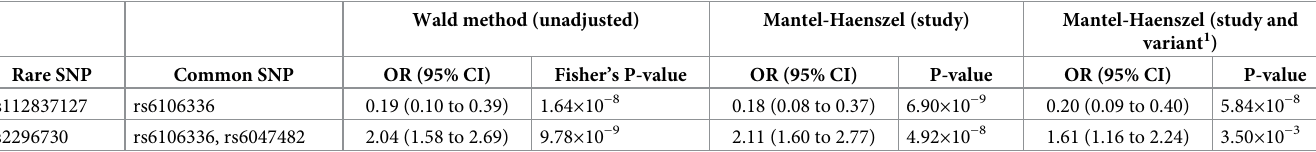
Models use a dominant allele coding for minor alleles with each individual as the analysis unit. 1 Adjustment for contributing study and nearby common